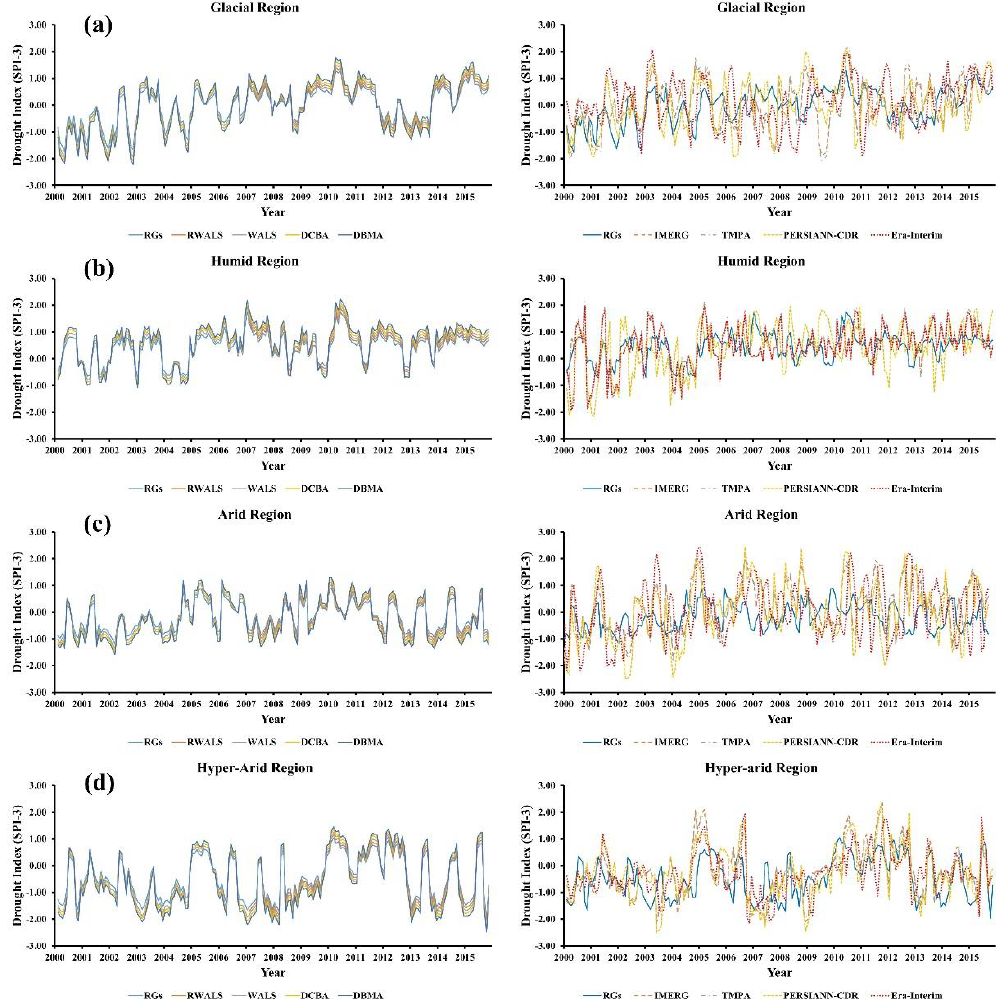
Figure 9. ( a – d ) SPI-3 drought index estimated using RGs and MSPDs ( left panel ) and SPDs ( right panel ) across all four climate regions.